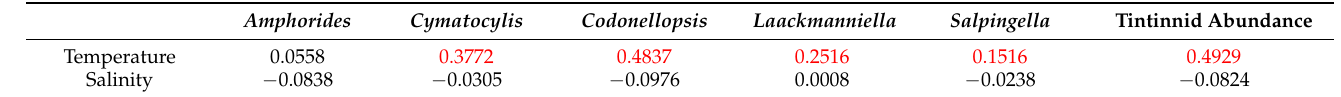
Table 5. Spearman correlations index calculated between abiotic factor and tintinnids abundances in the photic layer during the whole study period. Red marked correlations are significant at p < 0.05.